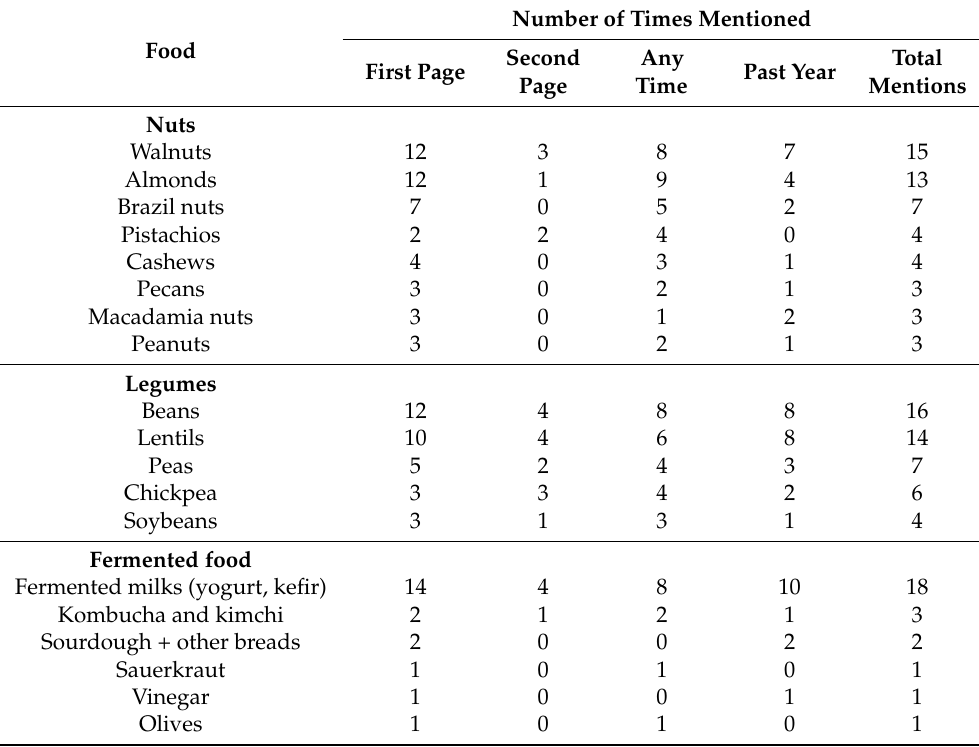
Table 6. Classification of nuts, legumes and fermented foods by the number of times that were mentioned on selected web pages.